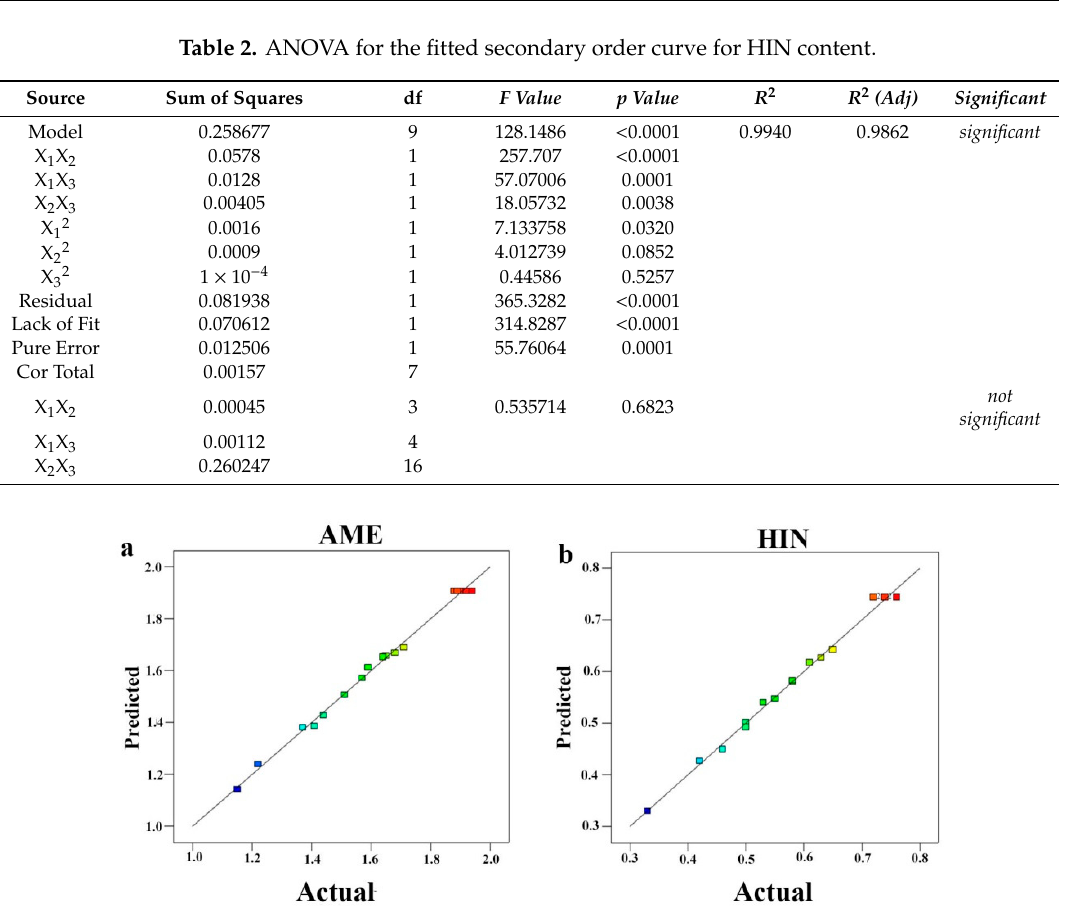
Figure 4. Correlation between the predicted and actual values for two biflavonoids content; ( a ) color points from blue to red show values of AME changing in the range of 1.0–2.0 mg/g; ( b ) color points from blue to red show values of HIN changing in the range of 0.3–0.8 mg/g. Table 1. ANOVA for the fitted secondary order curve for AME content.